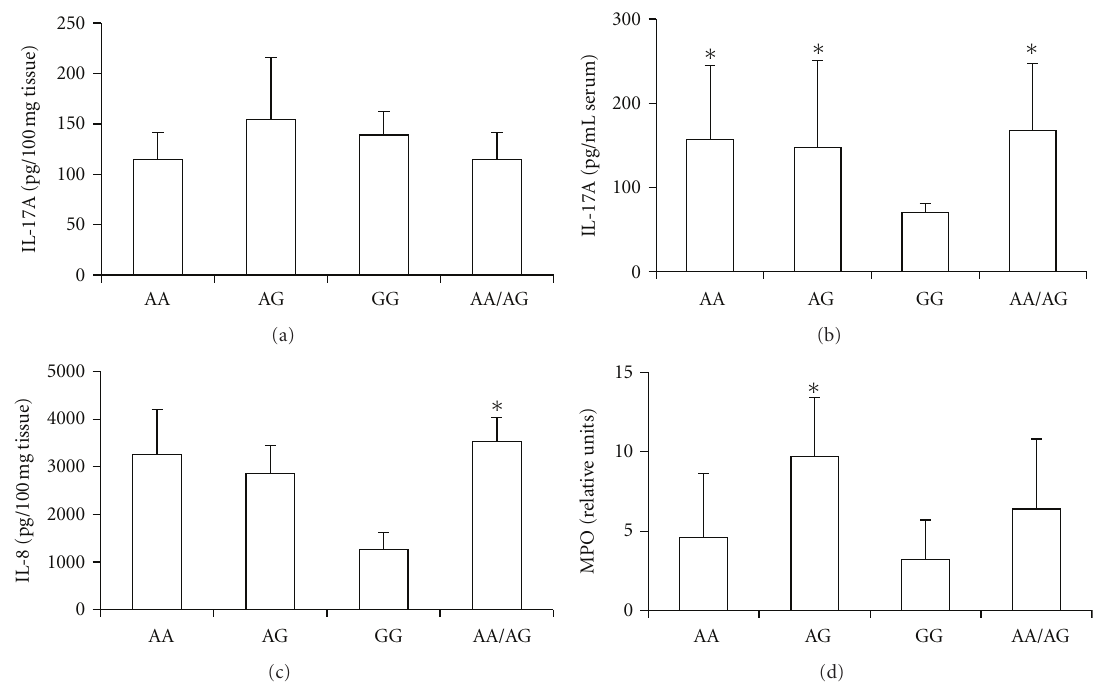
Figure 2: Levels of inflammatory mediators in chronic periodontitis patients according to each IL-17A G197A genotype. (a) Levels of IL- 17A in gingival tissues and (b) serum. (c) Levels of IL-8 and (d) MPO (myeloperoxidase) activity in gingival tissue samples. ∗ Statistically significant di ff erence ( P < 0 . 05) comparing with the genotype GG.